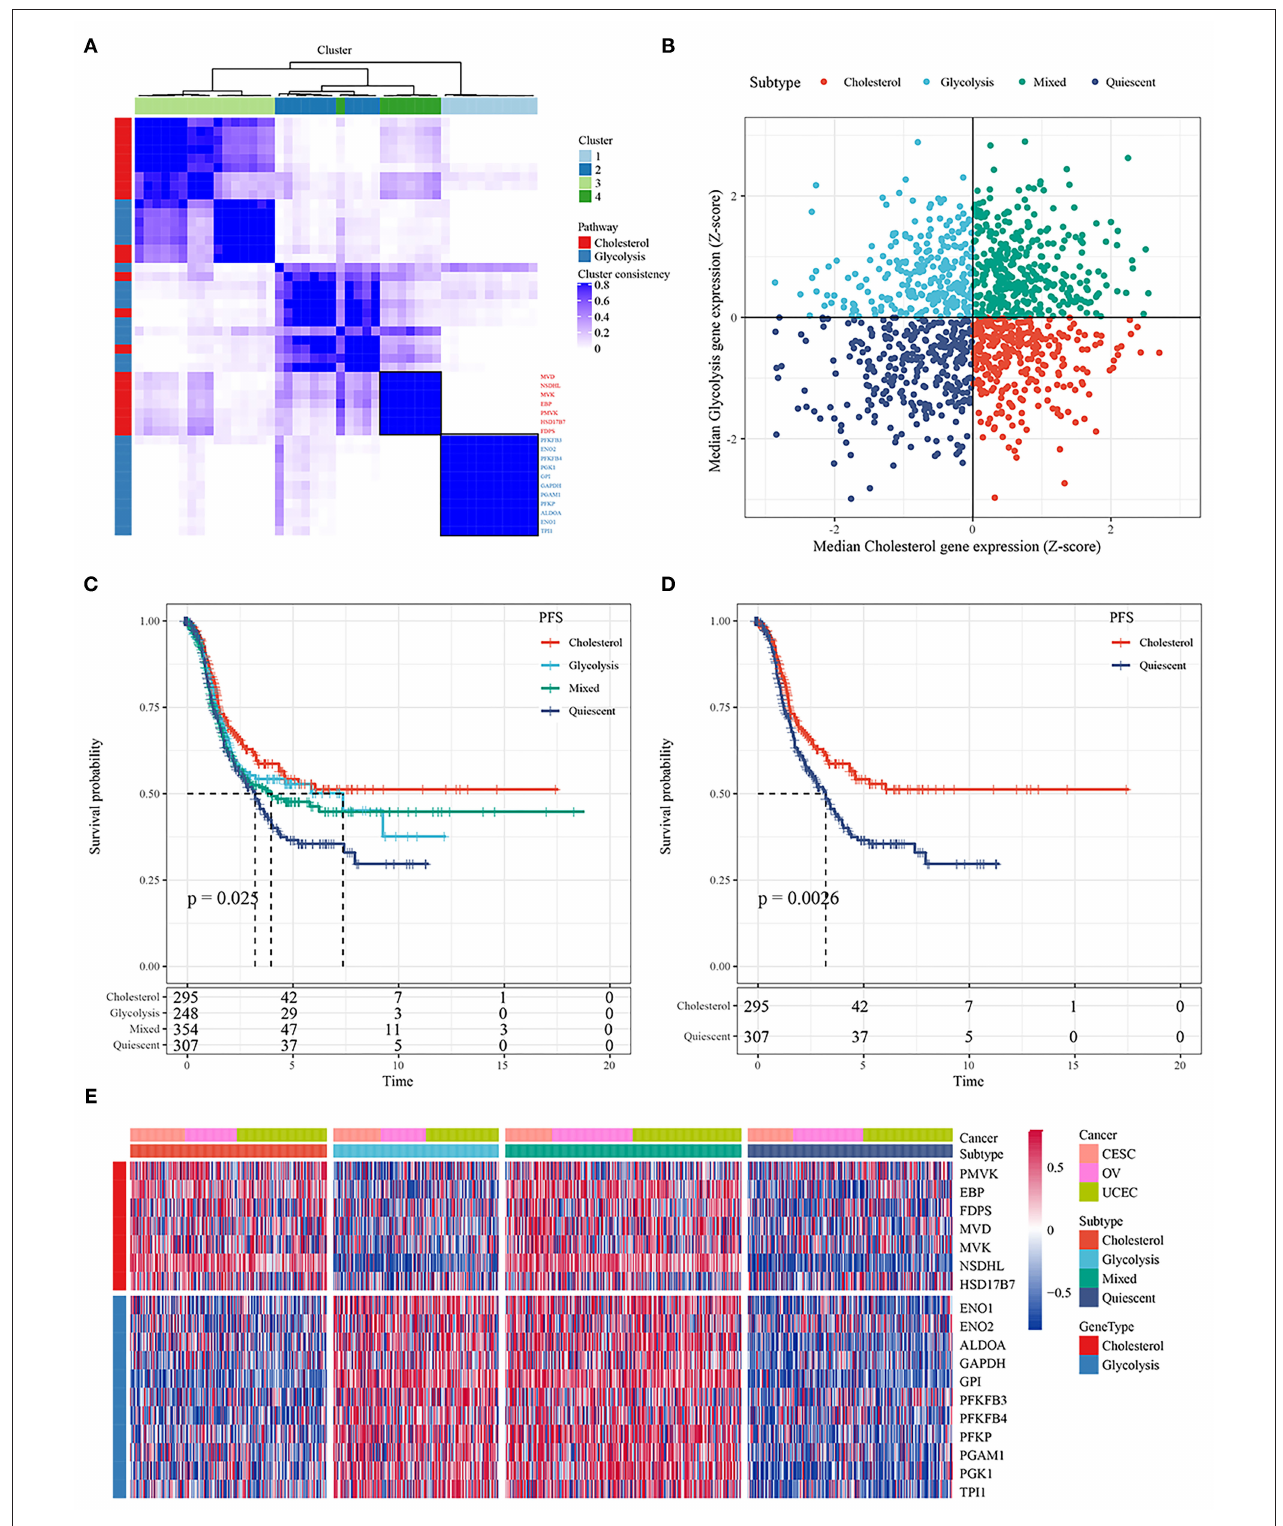
FIGURE 1 | (A) Consistent clustering of glycolysis and cholesterol genes; (B) Classification of samples according to glycolysis and cholesterol gene expression; (C) PFS curve of four molecular subtypes in TCGA ovarian cancer samples; (D) PFS curve between cholesterol and quiescent subtype; (E) Cluster heatmaps of 18 related